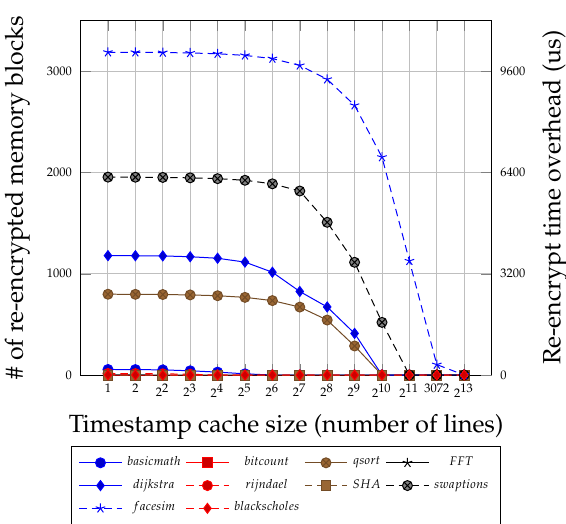
Figure 7. The number of re-encrypted memory blocks by varying the timestamp cache size.